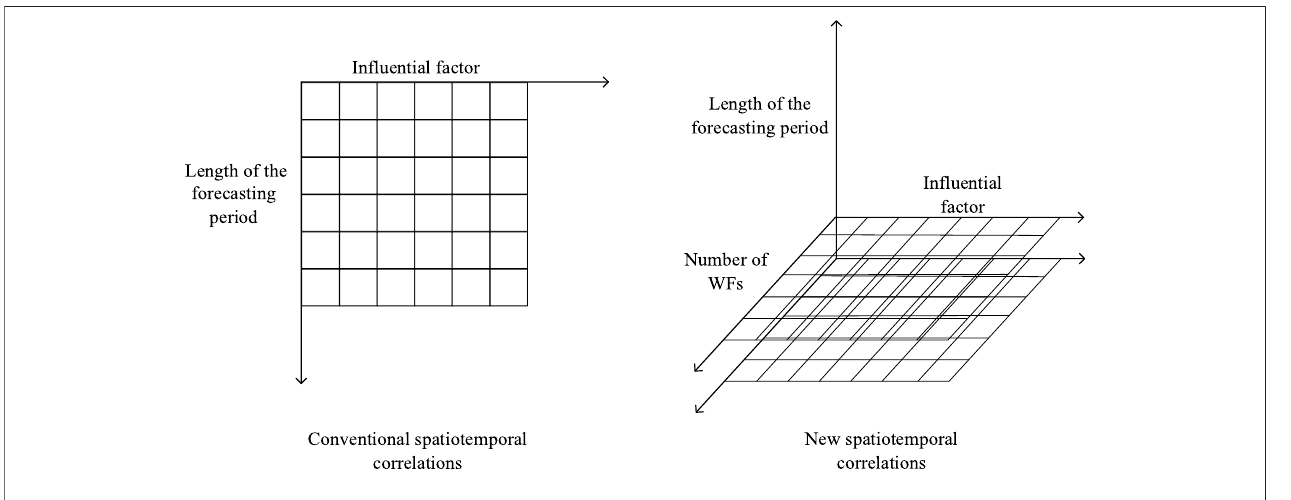
FIGURE 1 | Traditional and new spatiotemporal correlation